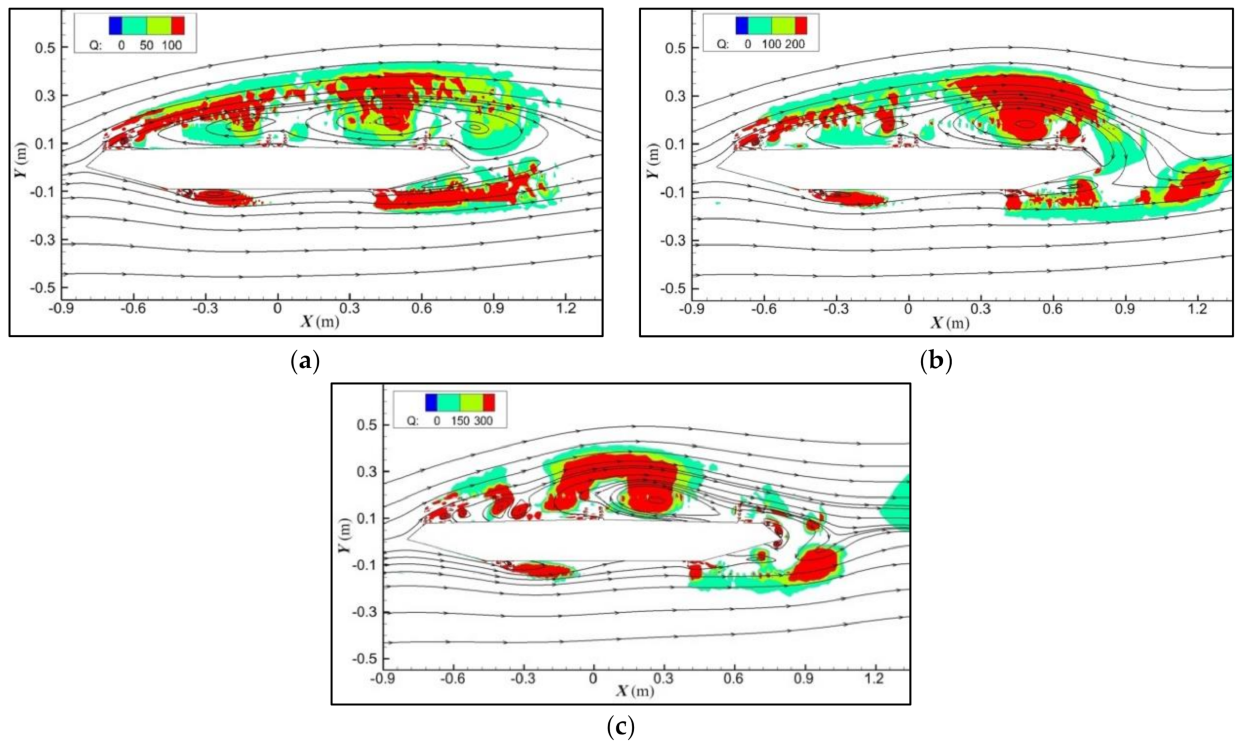
Figure 5. Contours of time-averaged vortex structures at 0 moment (Unit: s − 1 ). ( a ) Rapid develop- ment stage of VIV. ( b ) Gradual convergence stage of VIV. ( c ) Stable vibration stage of